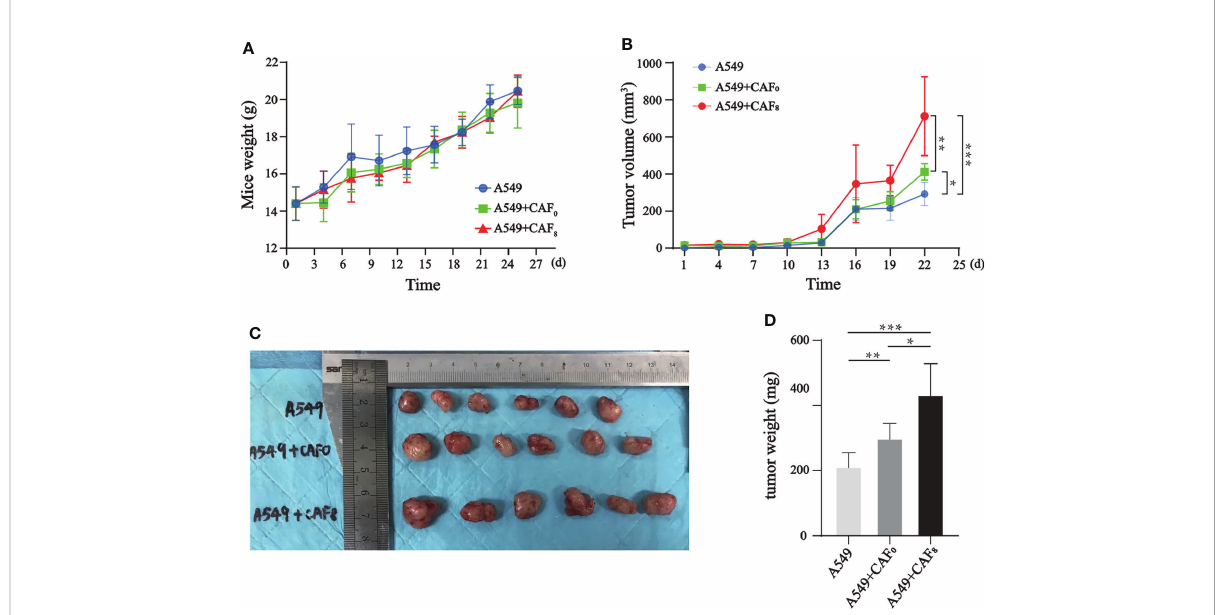
FIGURE 7 CAFs promoted the tumor volume and weight of the A549 cells tumor model after ionizing irradiation. (A) The line graph of mice weight showed that differences of body weight changes for each mouse in different groups was no signi fi cant; (B) The line graph of tumor volume indicated that CAF 8 had the greatest promotion on the tumorigenicity of A549 cells; (C) An overview of implanted tumors in three subgroups revealed that the tumor volume of the A549+CAF8 group was the biggest, and the A549 group was the smallest; (D) The tumor volume was measured for each group of mice and the t-test was applied for statistical analysis. The histogram displayed that CAF8 had the strongest promotion on the tumorigenicity of A549 cells. (T-test, data are presented as the mean ± S.D. *P < 0.05, **P < 0.01, ***P < 0.001).